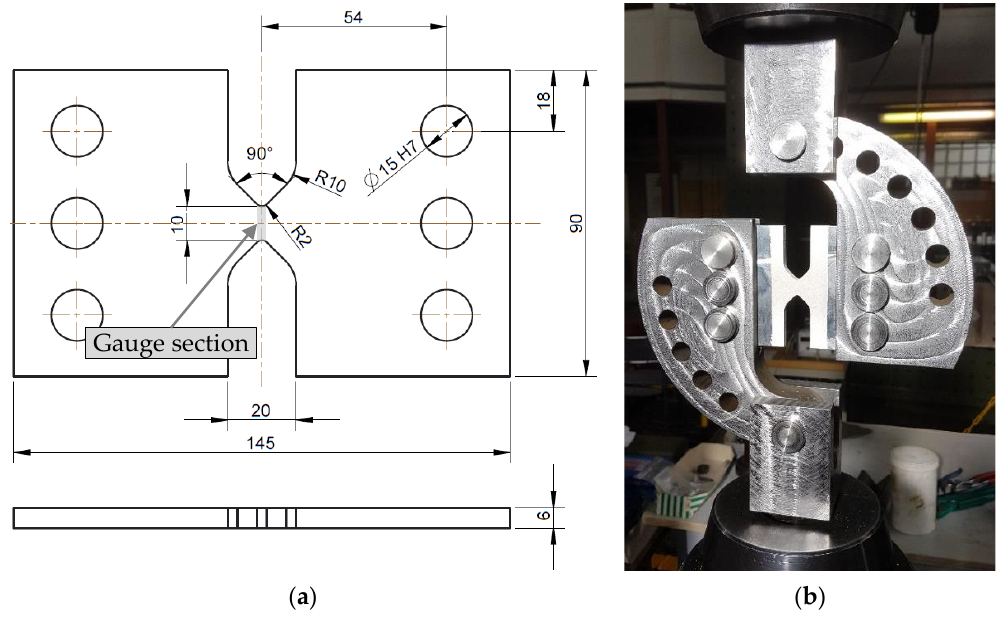
Figure 4. ( a ) Geometry of the shear specimen; ( b ) shear specimen mounted in the corresponding loading device for testing in a uniaxial testing machine.